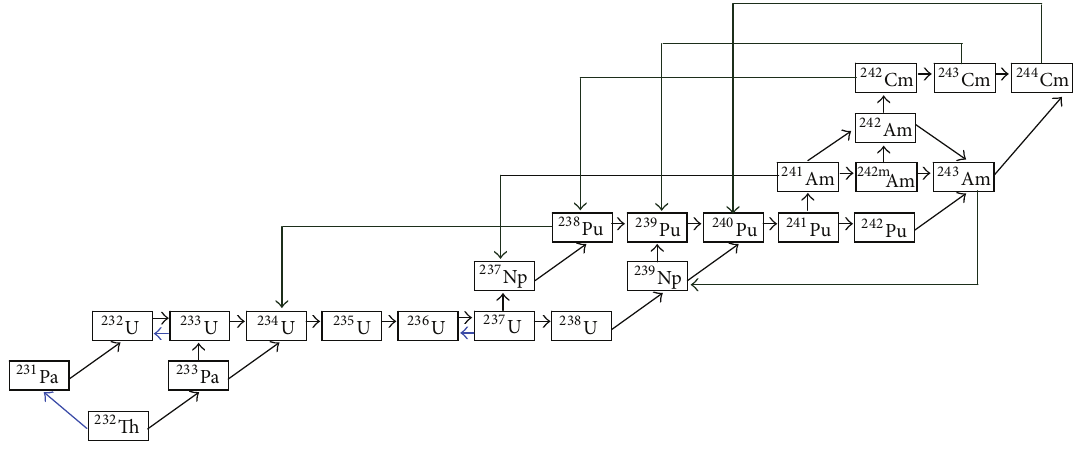
Figure 8: Depletion chain for actinides tracked in TANG code.